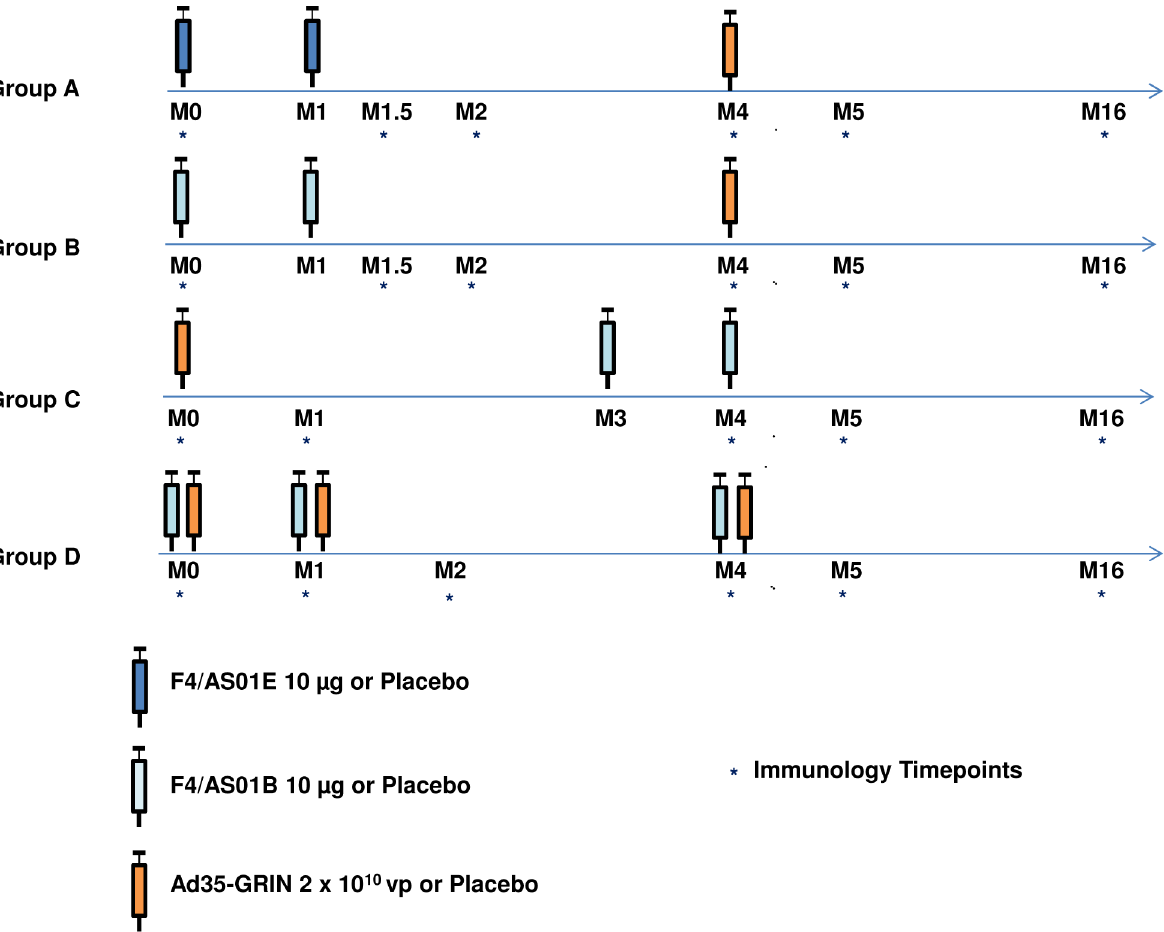
Fig 1. Study Schema. Enrolled volunteers were randomized to one of the 4 regimens (groups A, B, C, or D), with approximately 28 vaccine and 7 placebo recipients per group, receiving 0.5 mL (F4/AS01 E or F4/AS01 B ) and/or 1.0 mL (Ad35-GRIN) injections of vaccine or placebo. Vaccinations were given at baseline, month 1 (M1) or month 3 (M3), and month 4 (M4).